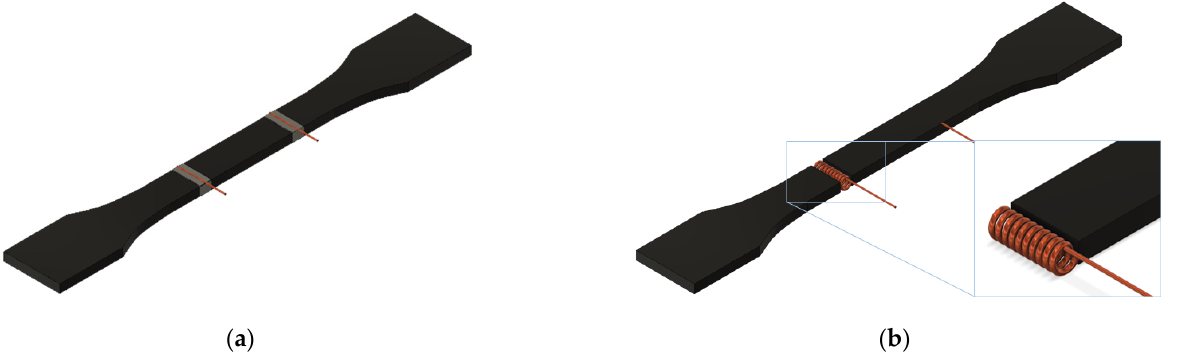
Figure 2. Electrode disposition in strain monitored tensile test: ( a ) conventional form (copper wire is around the nanocom- posite surface with silver ink), ( b ) alternative form (copper wire is embedded in a solenoid form).